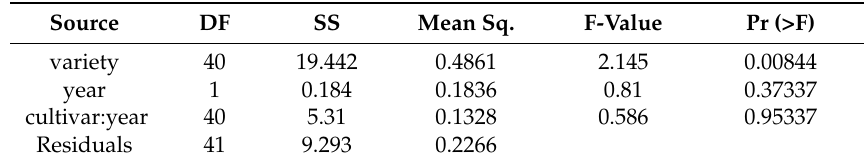
Table 6. Results of an analysis of variance (ANOVA) showing an interaction output for t -pterostilbene content by year from different muscadine grape cultivars (2013–2015).